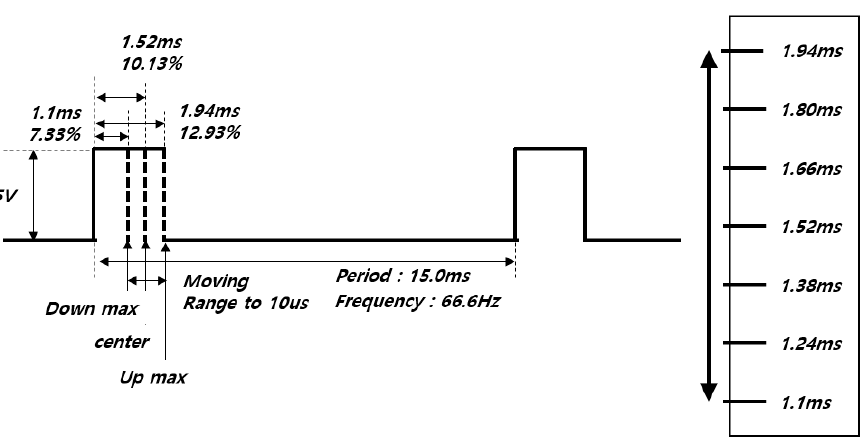
Figure 3. The motor control signal at the controller in the quad-rotor. ※ Travel time: signal range limited to a maximum signal duration from 1.1 ms to 1.94 ms.